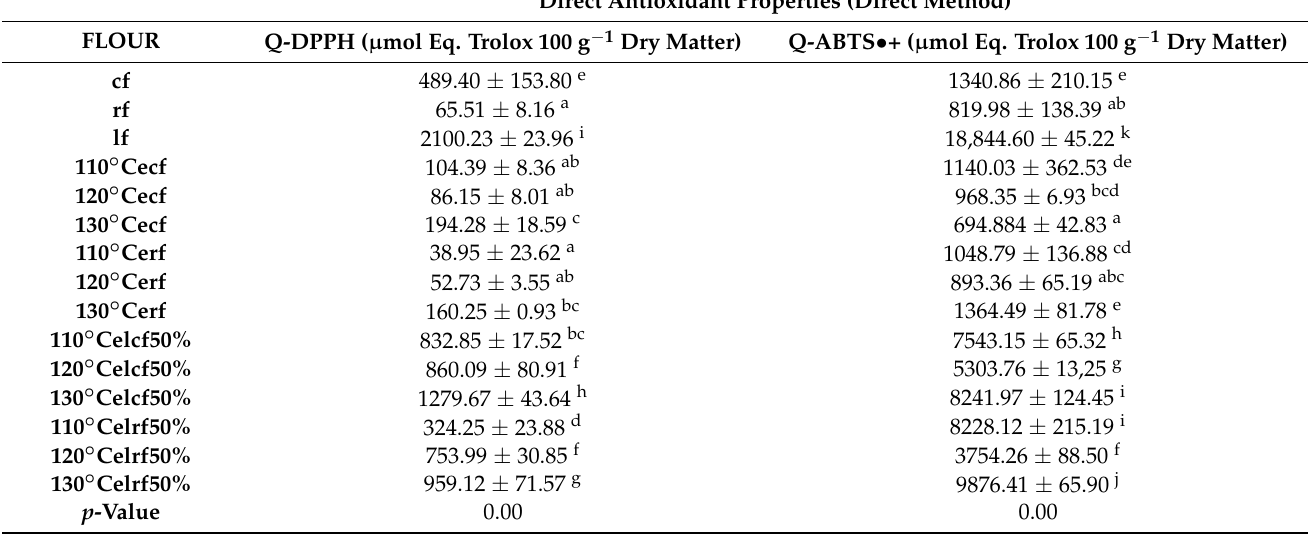
Table 3. Direct antioxidant properties Q-DPPH and Q-ABTS • + ( µ mol Eq. Trolox 100 g − 1 dry matter) of native and extruded